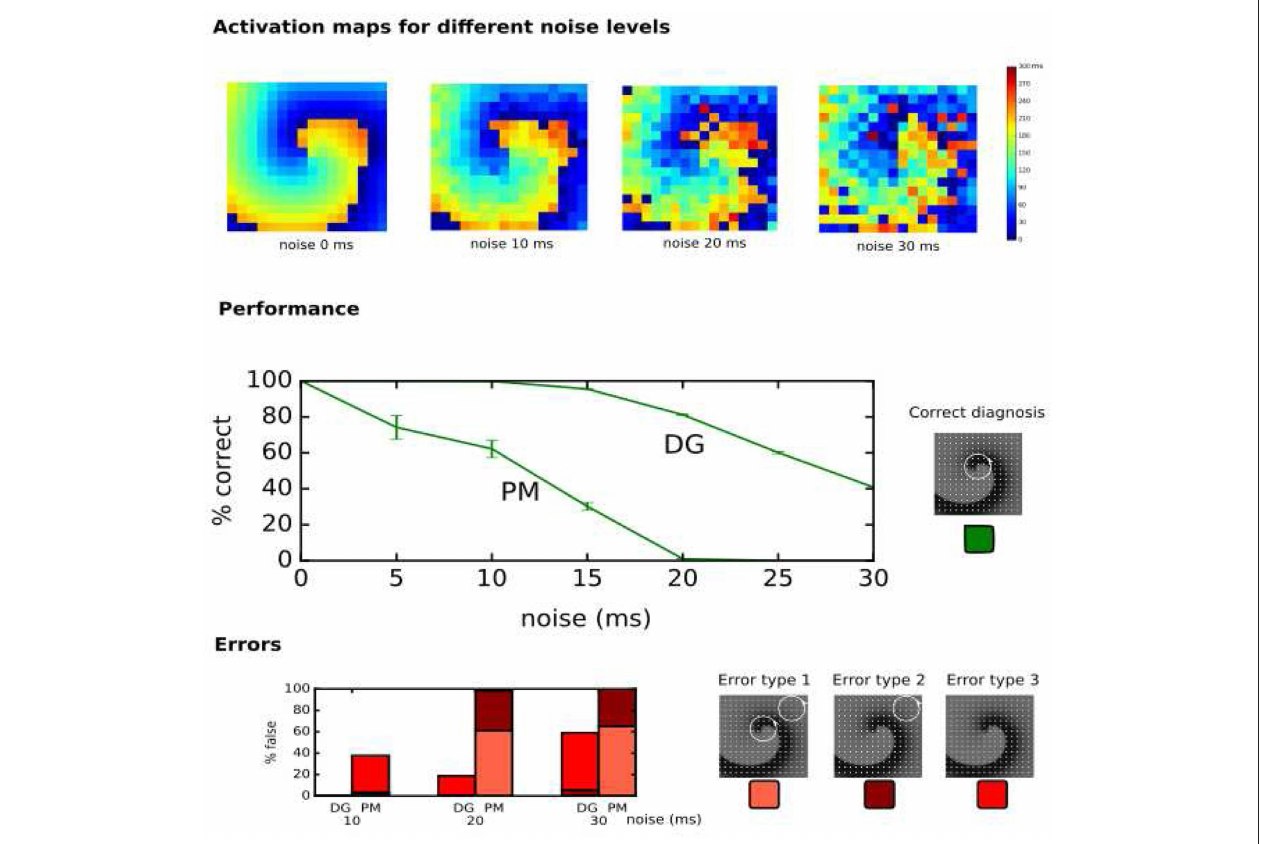
FIGURE 7 | Performance of DG mapping and phase mapping (PM) while adding Gaussian noise with an increasing standard deviation (ranging from 0 to 30 ms) in a single 2D rotor model with 256 electrodes. The upper panels show representative activation maps for different levels of noise. The middle panel shows the performance of DG mapping vs. phase mapping for these different noise levels. The bottom panel shows the type of errors in case of failure for both methods. Error type 1 is a detection of a false core in addition to the correct core, error type 2 is only a detection of a false core and error type 3 is no detection of cores at